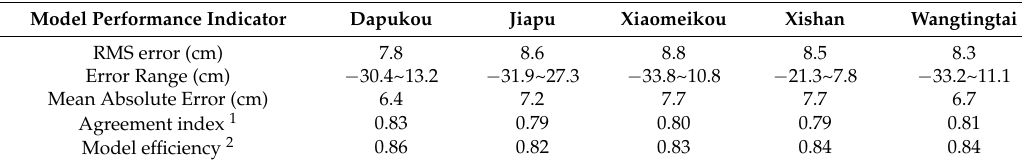
Table 3. Model behavior with 500 m grid